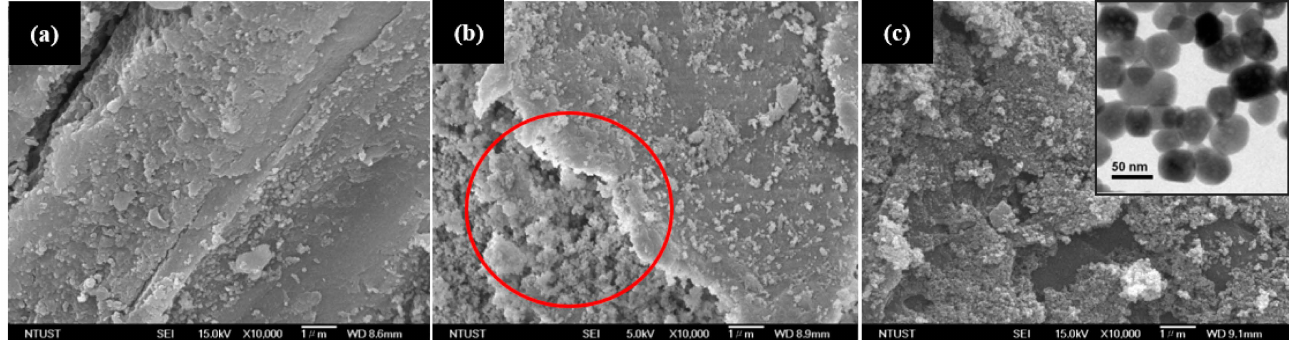
Figure 1. Images of FE-SEM of sugarcane bagasse ( a ) before treatment (SB), ( b ) after delignification (SB-D), and ( c ) amine- functionalized magnetic sugarcane bagasse biocomposites (SB-MH), (( c ), inset) TEM image of magnetic